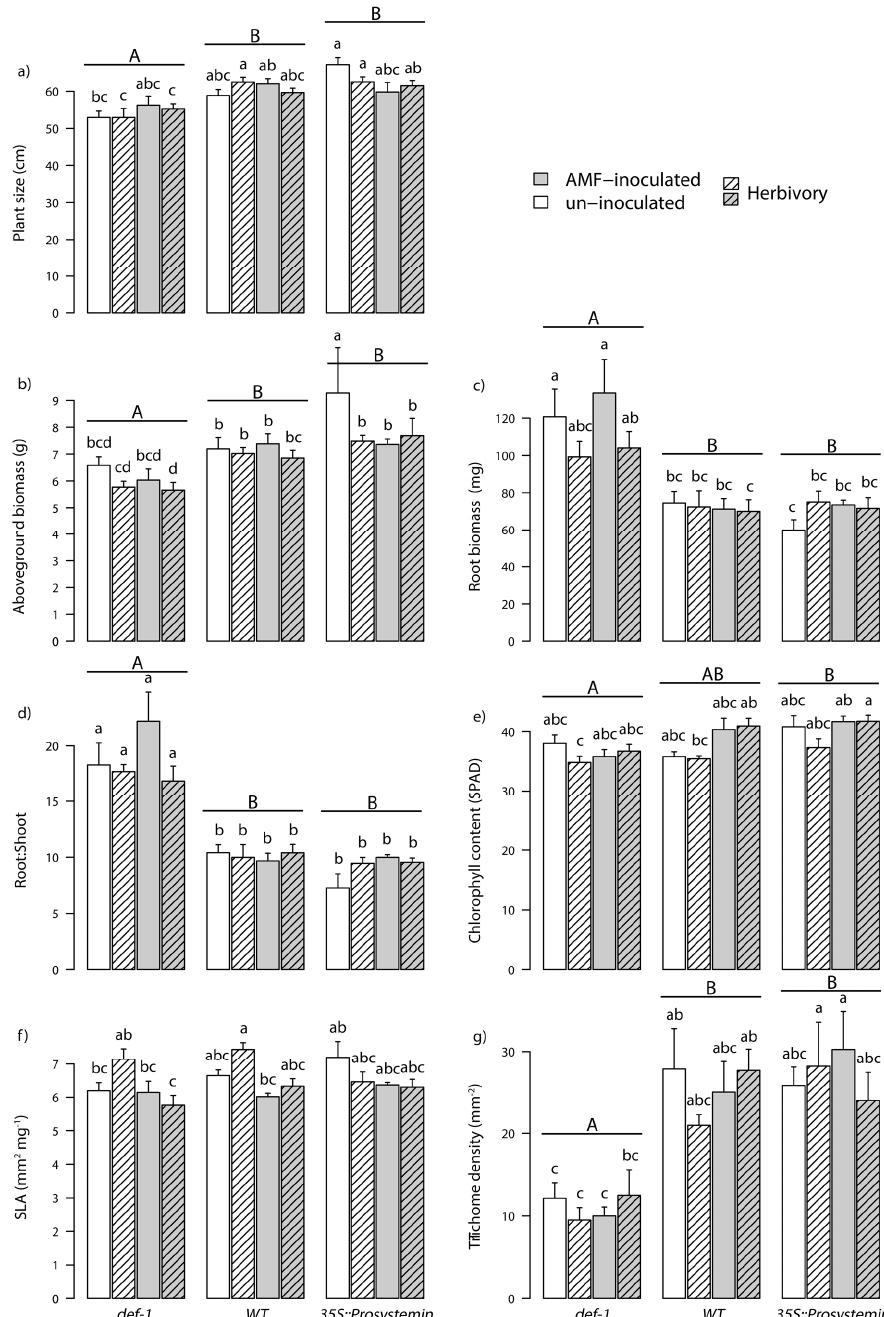
Figure 1. Tomato plants growth and defense traits (mean ± standard error (SE)), including ( a ) plant size ( n = 102), ( b ) plant biomass ( n = 100), ( c ) roots biomass ( n = 65), ( d ) roots:shoots ratio ( n = 65), ( e ) chlorophyll content ( n = 103), ( f ) specific leaf area (SLA; n = 66), ( g ) and trichome density ( n = 66). The plants have different genotype: jasmonic acid (JA) expression deficient plants (def-1), wild-type plants (WT), and prosystemin constitutive expression (35S::prosystemin) plants. Traits were measured after eight weeks of growth. Half of the plants were either inoculated with Arbuscular mycorrhizal fungi (AMF) (grey bars) or left un-inoculated (white bars). Dashed line bars represent plants treated with S. littoralis for 7 d. Lower case letters above bars represent pairwise significant difference across all treatments’ combination after Tukey’s mean separation test ( p < 0.05). Capital letters above bars represent difference across tomato